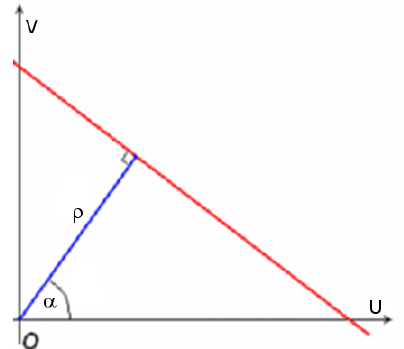
Figure 3. The parameter space ( ρ,α ) of the Hough transform adopted for line detection.